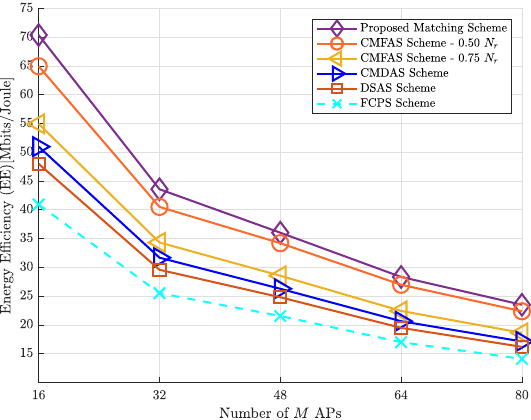
Figure 5. EE versus number of APs, where N r = 48 APs, N Q = 8, ρ = 23 dBm, and K = 8 UEs.